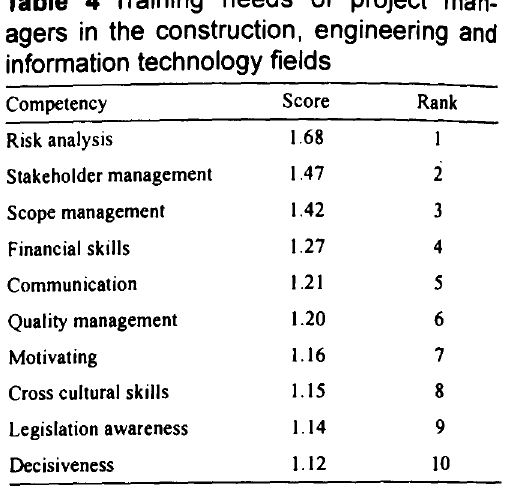
Figure I A South African competency model for project managers